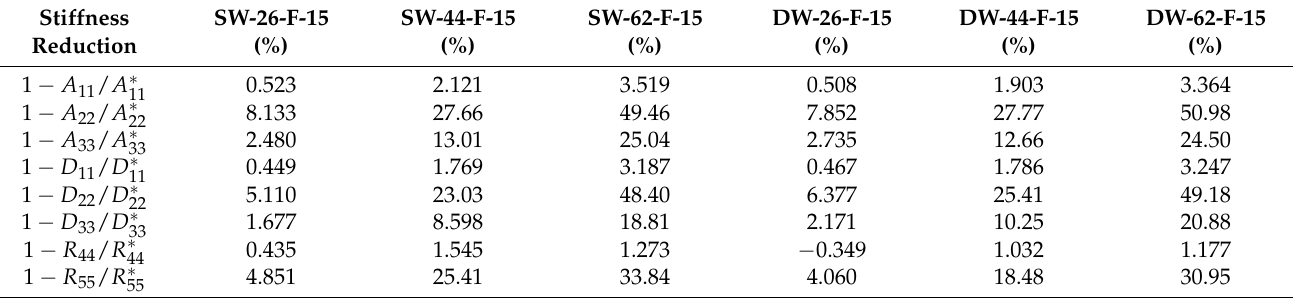
Table 9. Stiffness reduction for both SW and DW samples with flute rotated by 15 degrees for three cases of perforation. Stiffness